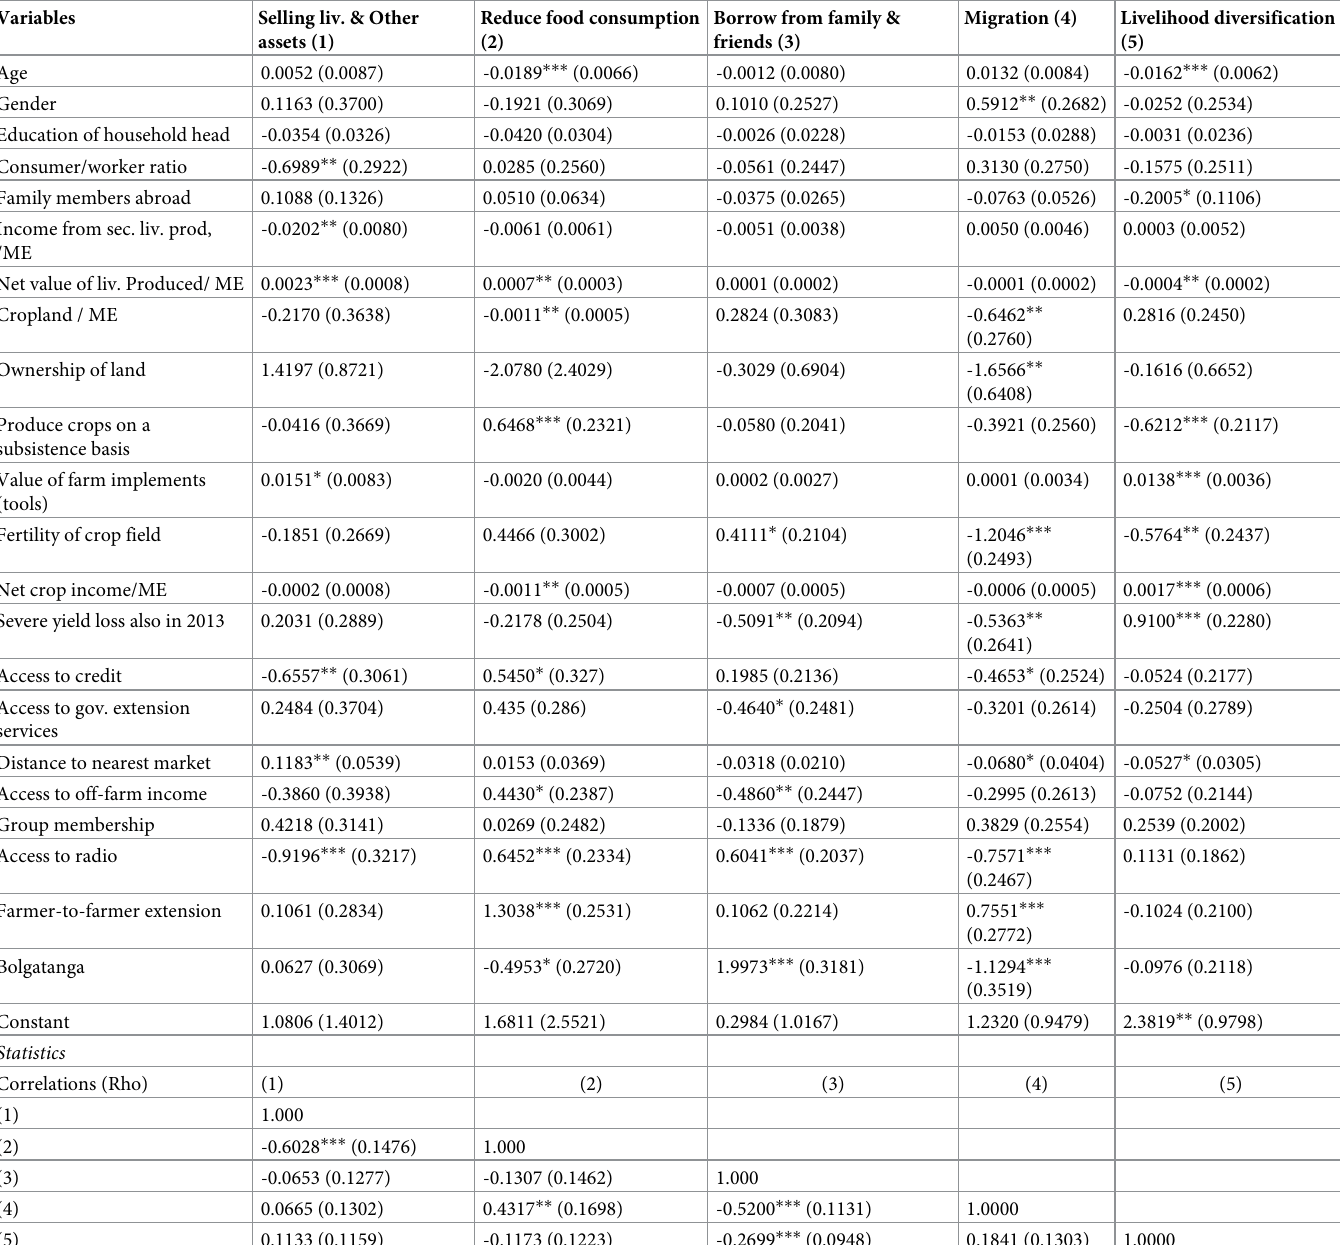
Table 3. Determinants of choice of farmers’ coping